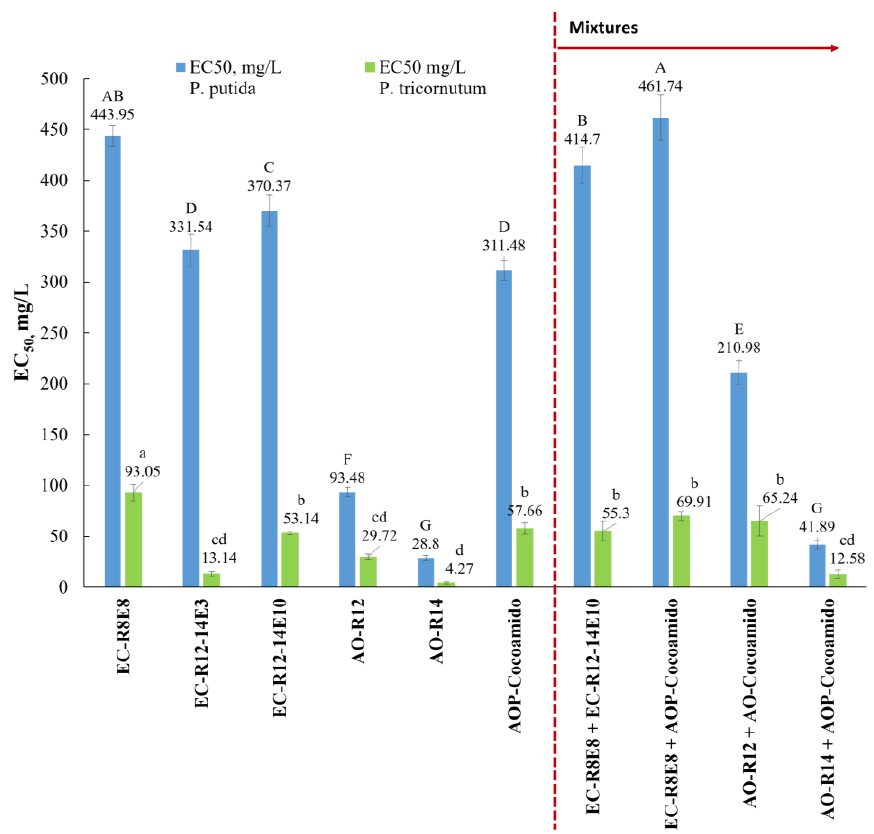
Figure 2. Toxicity values (95% CI) for individual and mixtures of surfactants. Mean values with different superscript letters (uppercase: P. putida ; lowercase: P. tricornutum ) are significantly different ( p < 0.05).